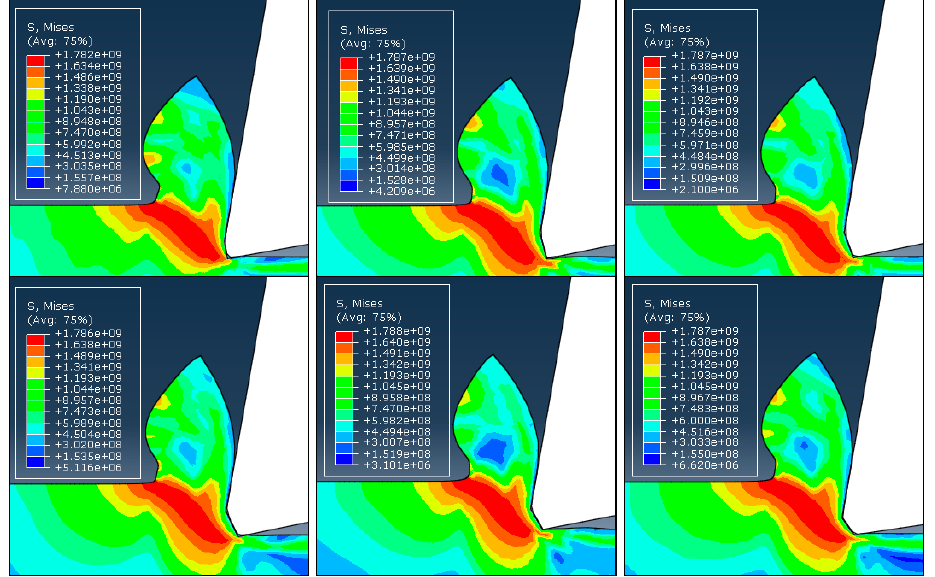
Figure 4. The distribution of stress with di ff erent chamfer angles. From top and left: − 10°, − 15°, − 20°, − 25°, − 30°, and − 35°.